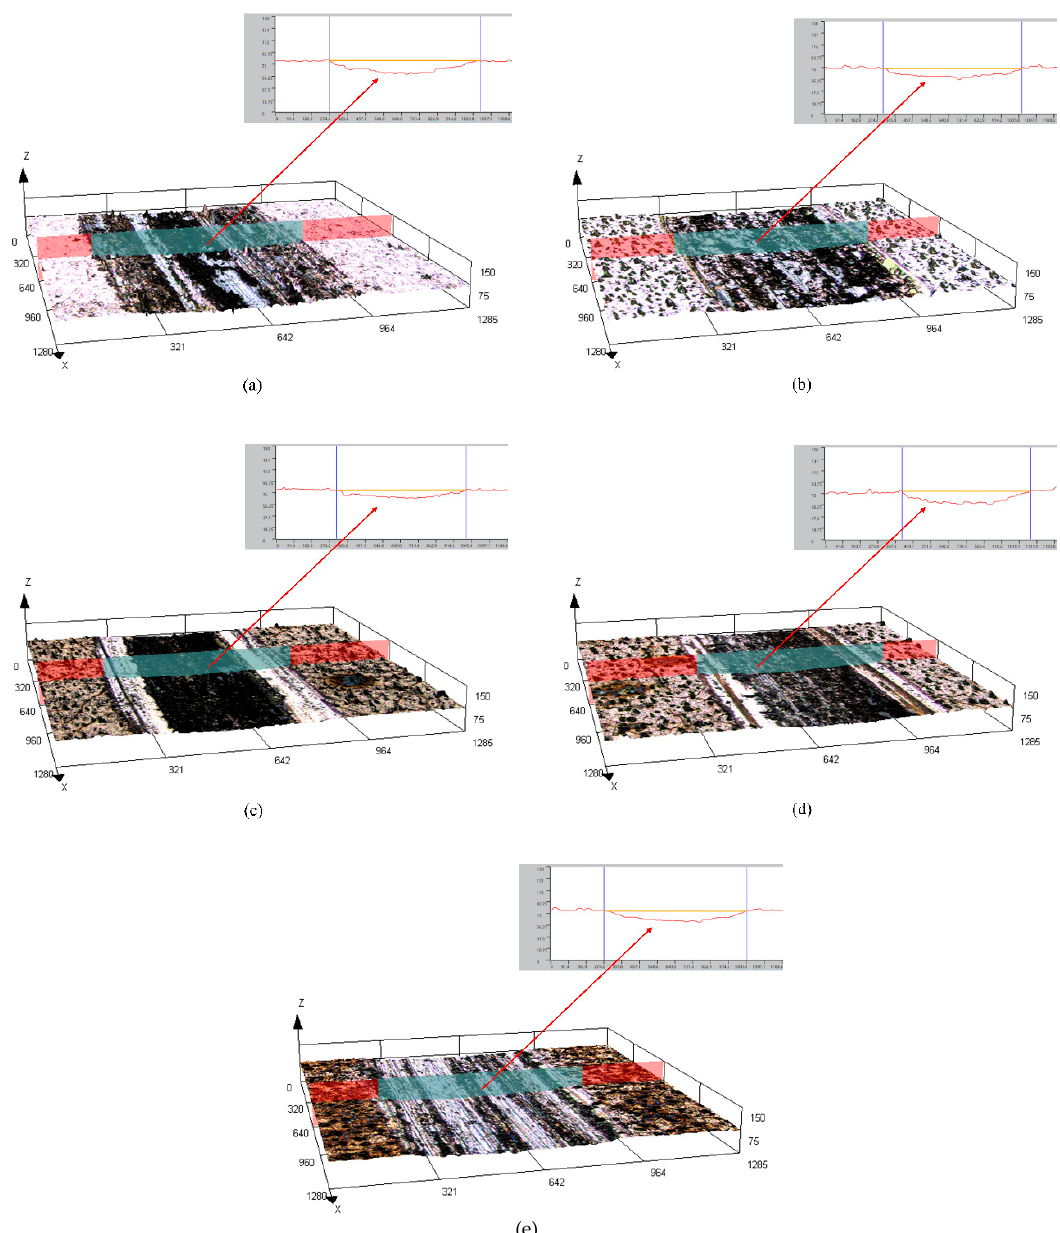
Figure 5. Effect of sodium citrate concentration on the wear mark morphology of coatings. ( a ) 0 g/L; ( b ) 20 g/L; ( c ) 40 g/L; ( d ) 60 g/L; ( e ) 80 g/L. Table 4. Effect of sodium citrate concentration on wear mark section parameter of coatings.